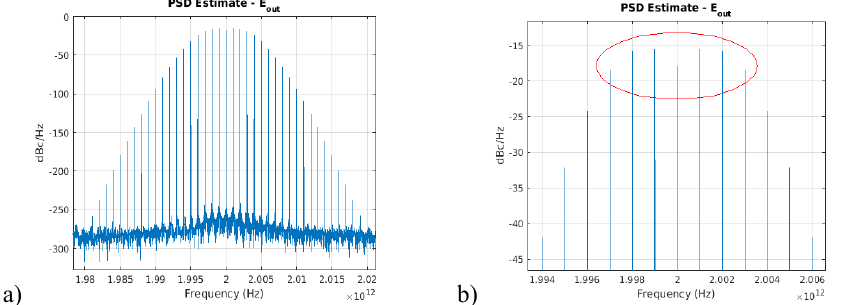
Fig. 2. Spectral density of the modulator output field for 1 GHz modulating frequency: full view (a) and zoom of the central lines (b). Modulation indices in the arms are 2 and 3.5. The red ellipse highlights the central lines with inequality of amplitudes less than 3 dB (7 lines in total). The optical frequency is chosen to be 10 12 Hz due to the limited computing power of the servers.